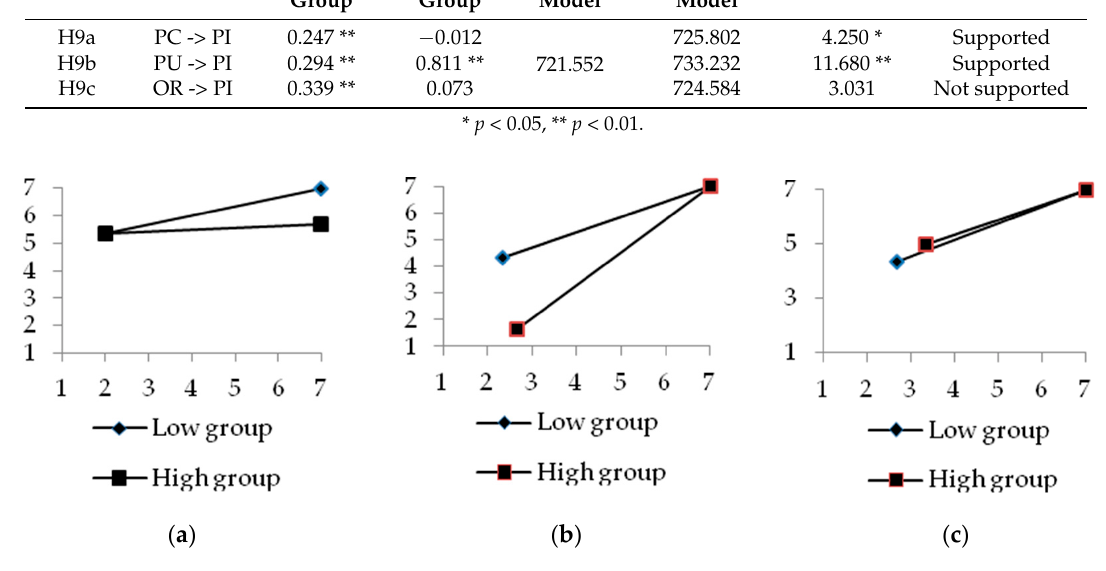
Figure 3. Plots of moderating effects. ( a ) PC -> PI; ( b ) PU -> PI; ( c ) OR -> PI.